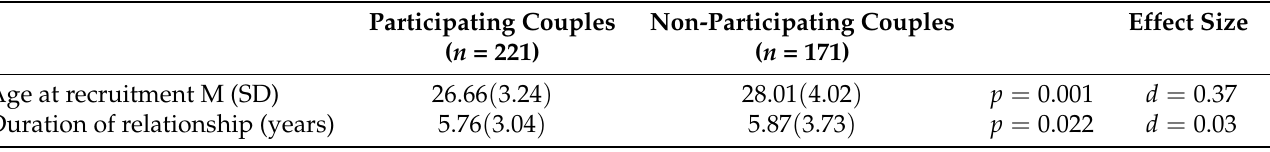
Table 1. Demographic characteristics of all couples who filled out the registration form with inclusion criteria.